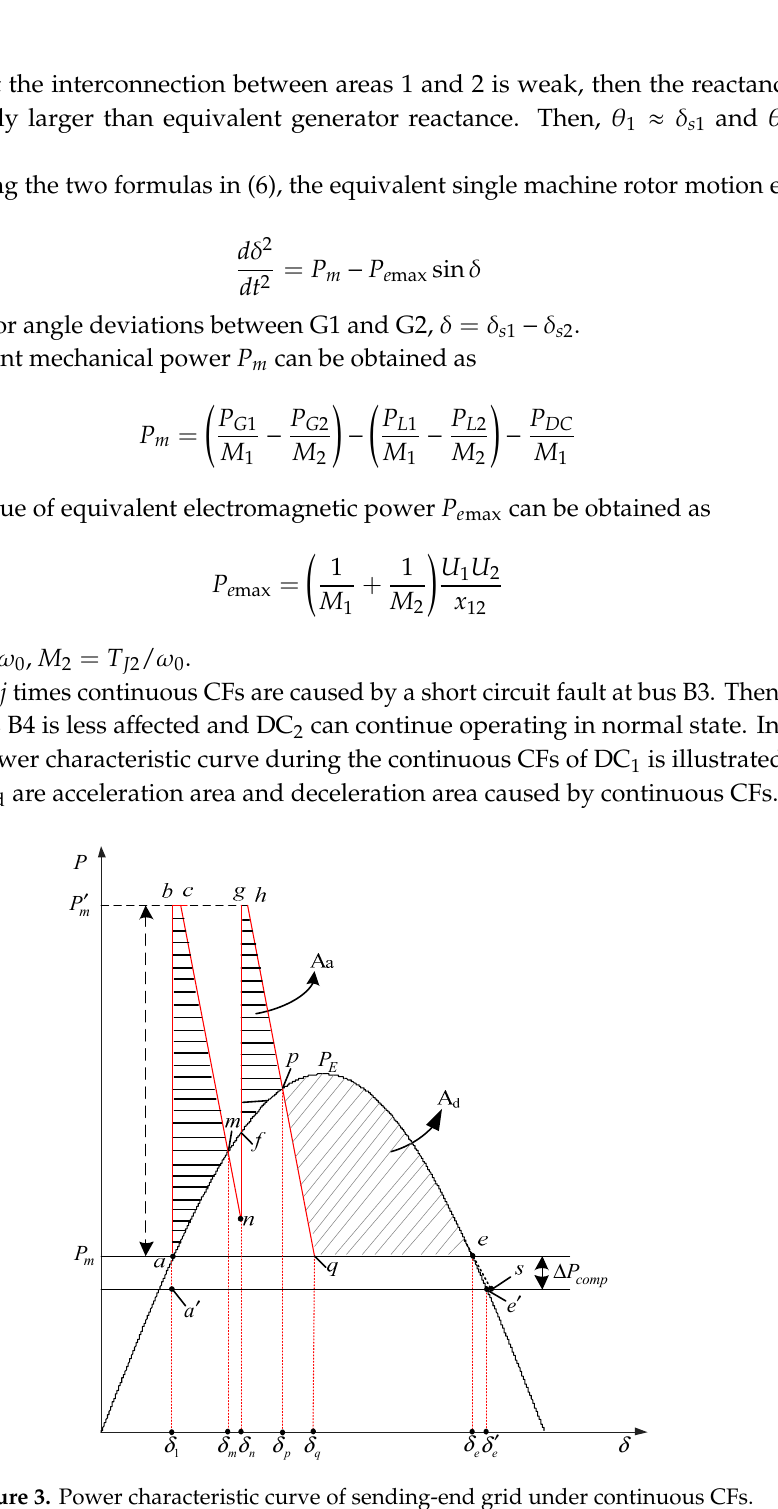
Figure 3. Power characteristic curve of sending-end grid under continuous CFs.